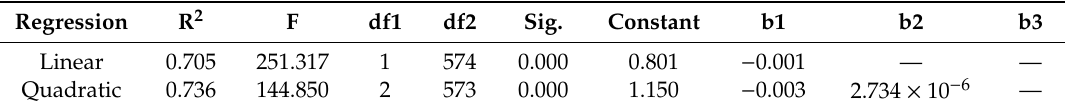
Table 10. Residuals, Akaike’s information criterion (AIC) and Bayesian information criterion (BIC)